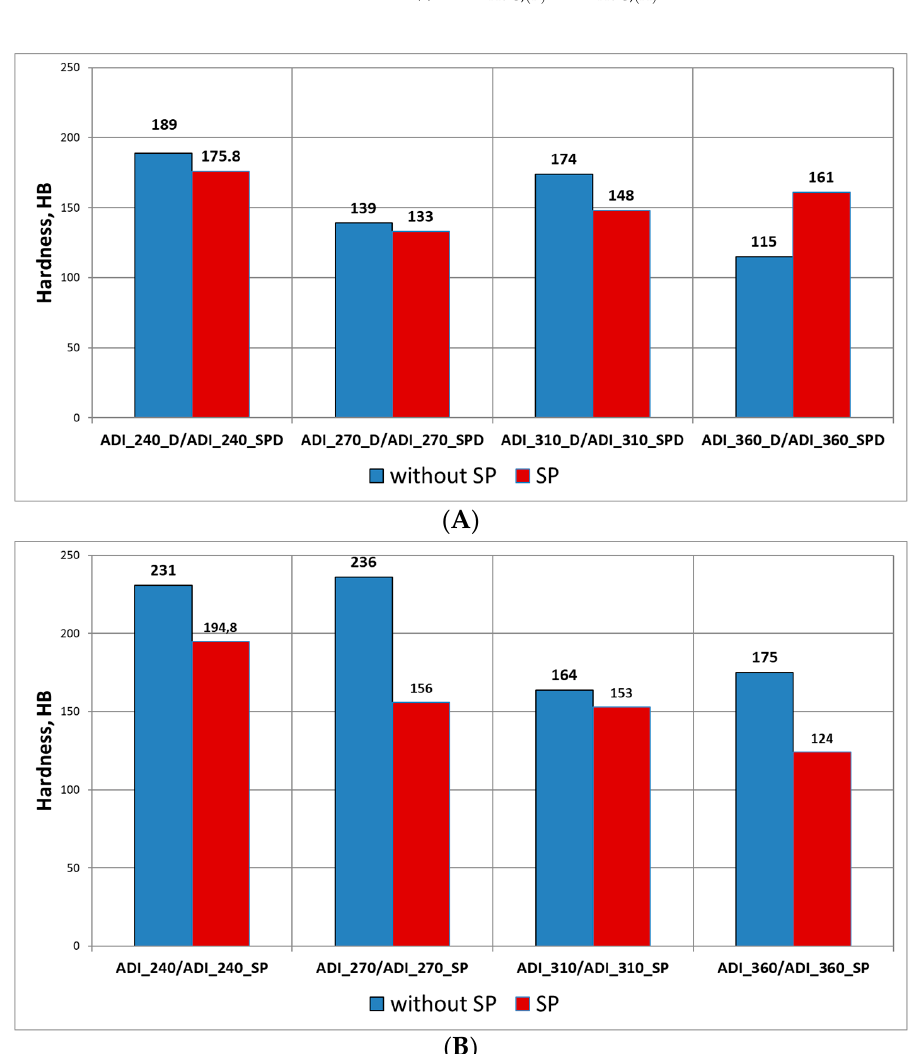
Figure 14. Change in the hardness of the operating surface layer in relation to the hardness of the technological surface layer: ( A ) after the wear test (Variant A), ( B ) after the wear test (Variant B).